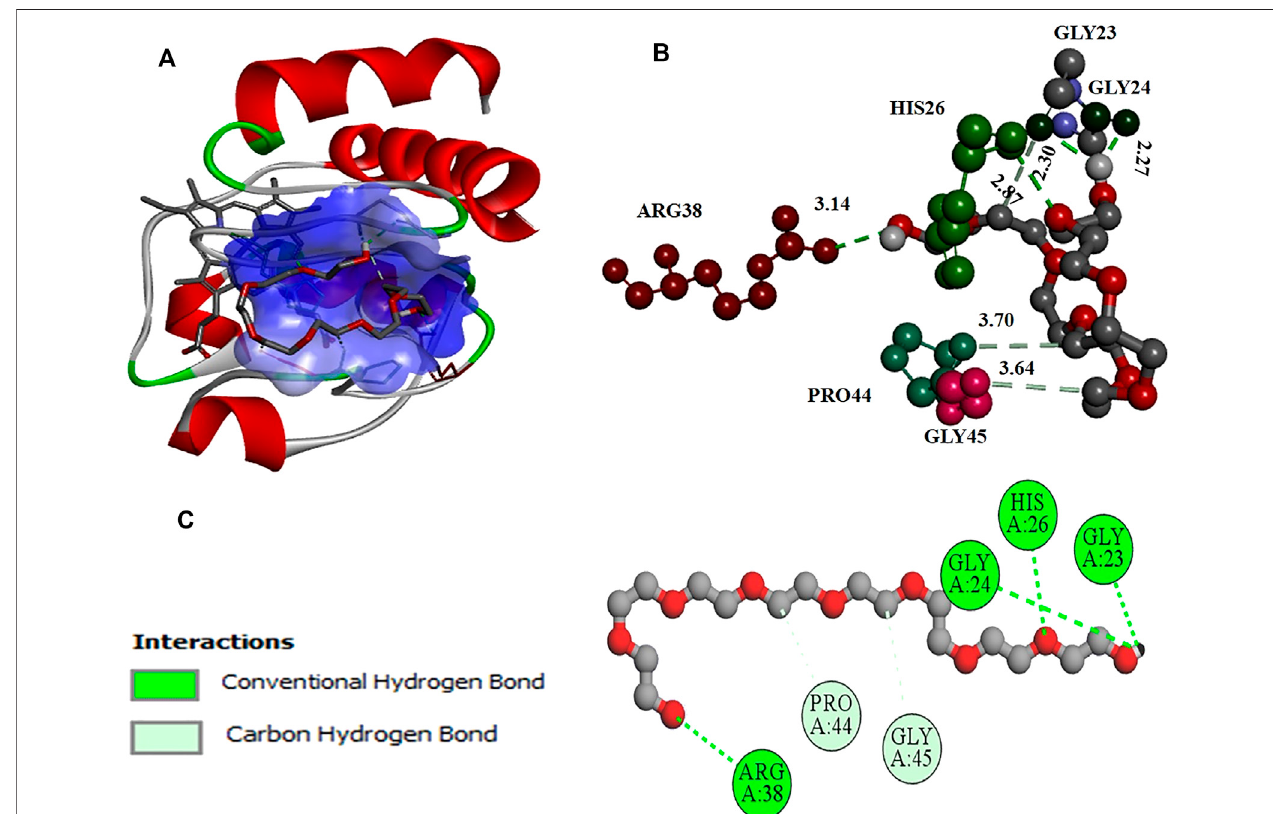
FIGURE 6 | (A) Surface area and binding site on the cyt c (cartoon model, red) for PEG 10 (stick model, gray). (B) Various amino acid residues (stick model) of the protein interacting with PEG 10 (ball and stick model, gray) with given bond lengths. (C) 2D representation of various types of interactions of amino acid residues with PEG 10.